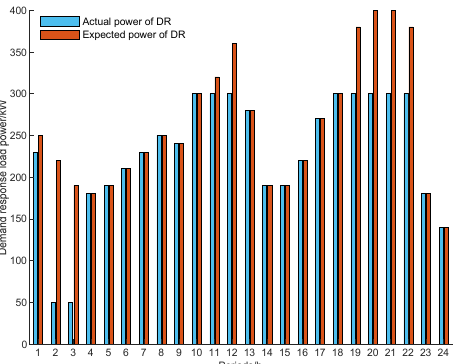
Figure 6. Charge and discharge power of the energy storage devices.